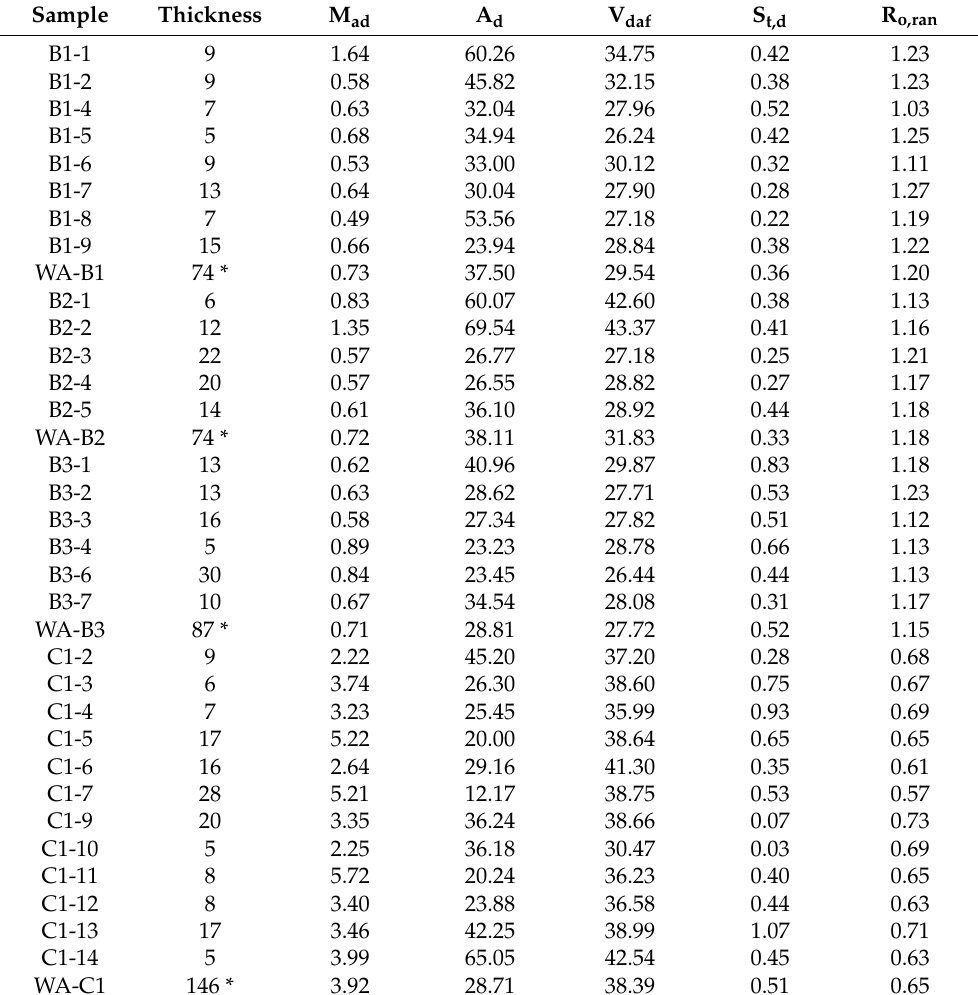
of collected samples from B1, B2, B3, and C1 coal